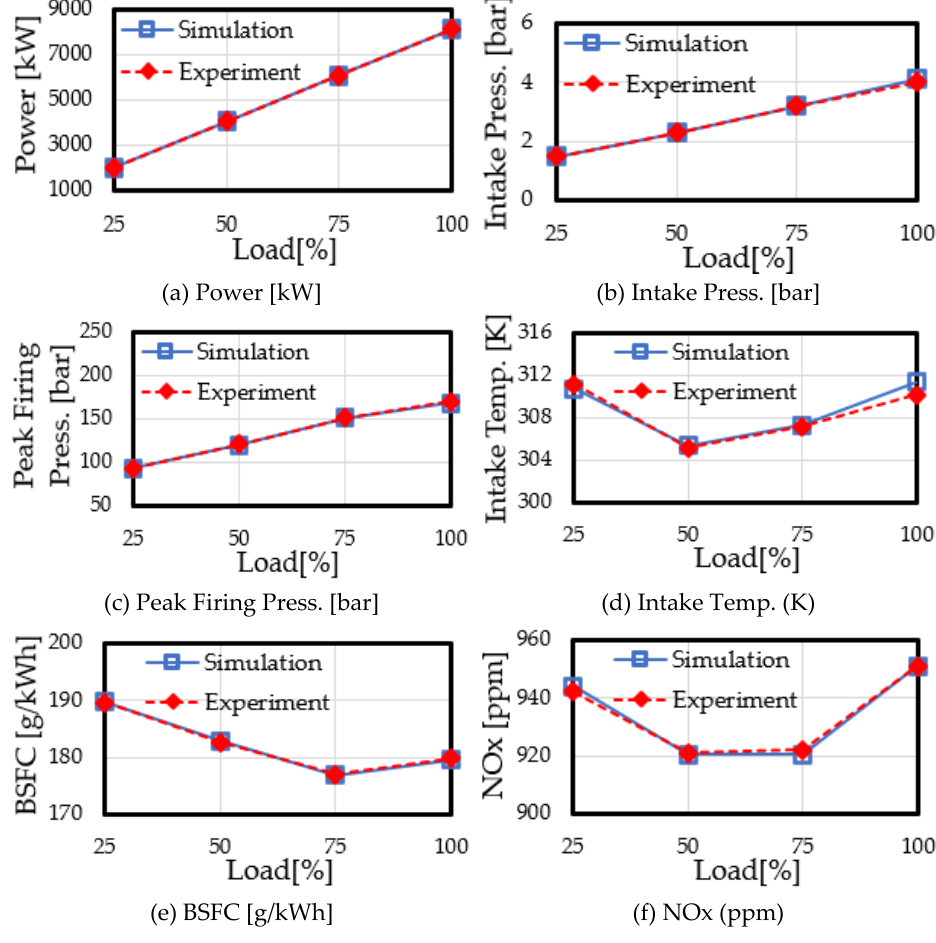
Figure 3. Validation results of primary parameter of the diesel mode. Table 4. Calculation error of the diesel mode.